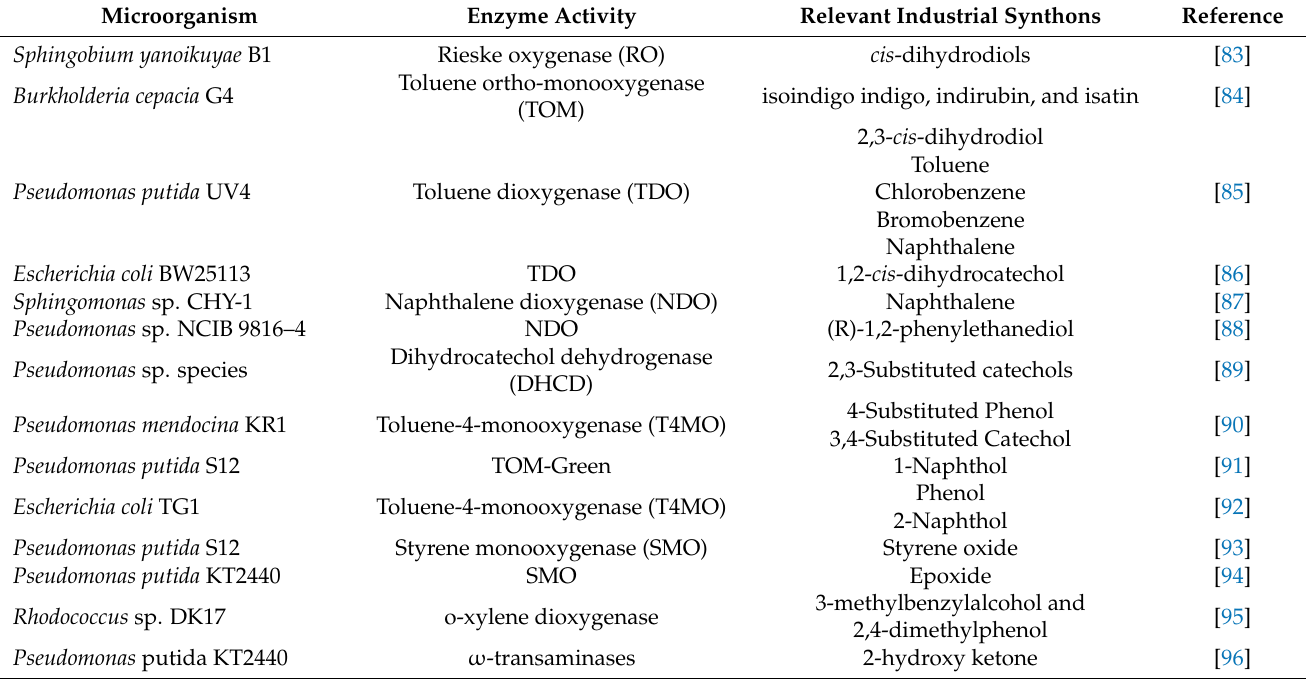
Table 1. A summary of recently reported microbes and enzymes employed in industrial synthesis. Microorganism Enzyme